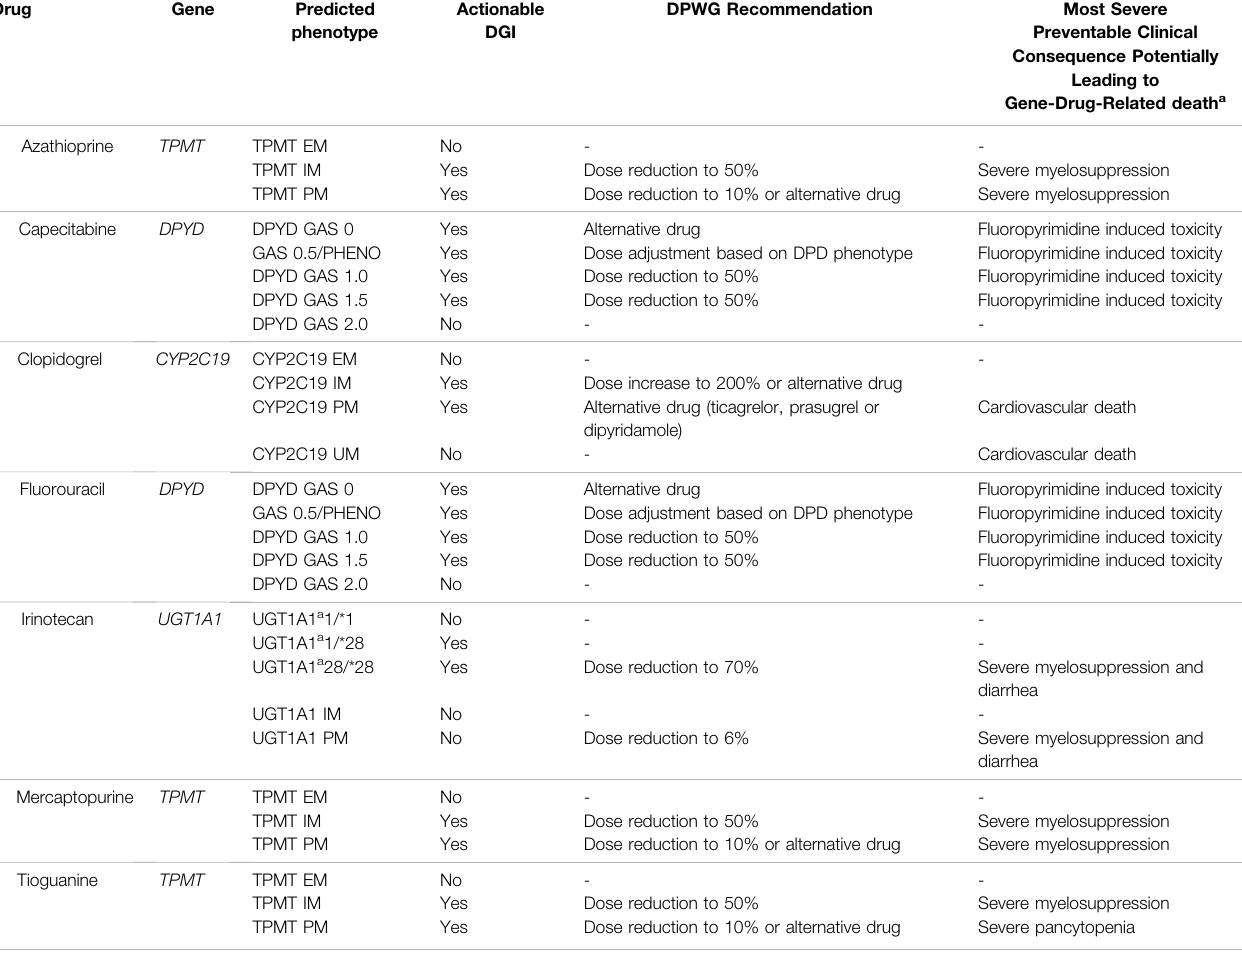
TABLE 1 | Selected “ essential ” gene-drug pairs, their potential consequences and DPWG recommendation per phenotype category. Drug